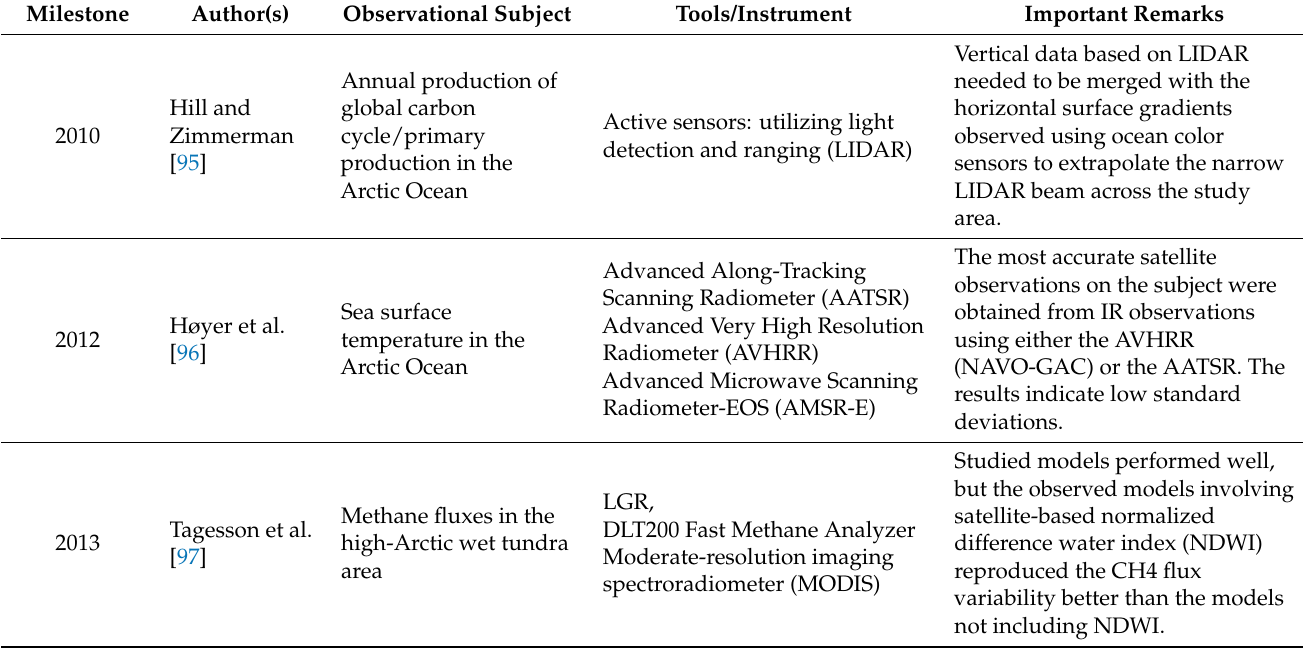
Table 5. Landmark research on the roles of sensors in Arctic studies and